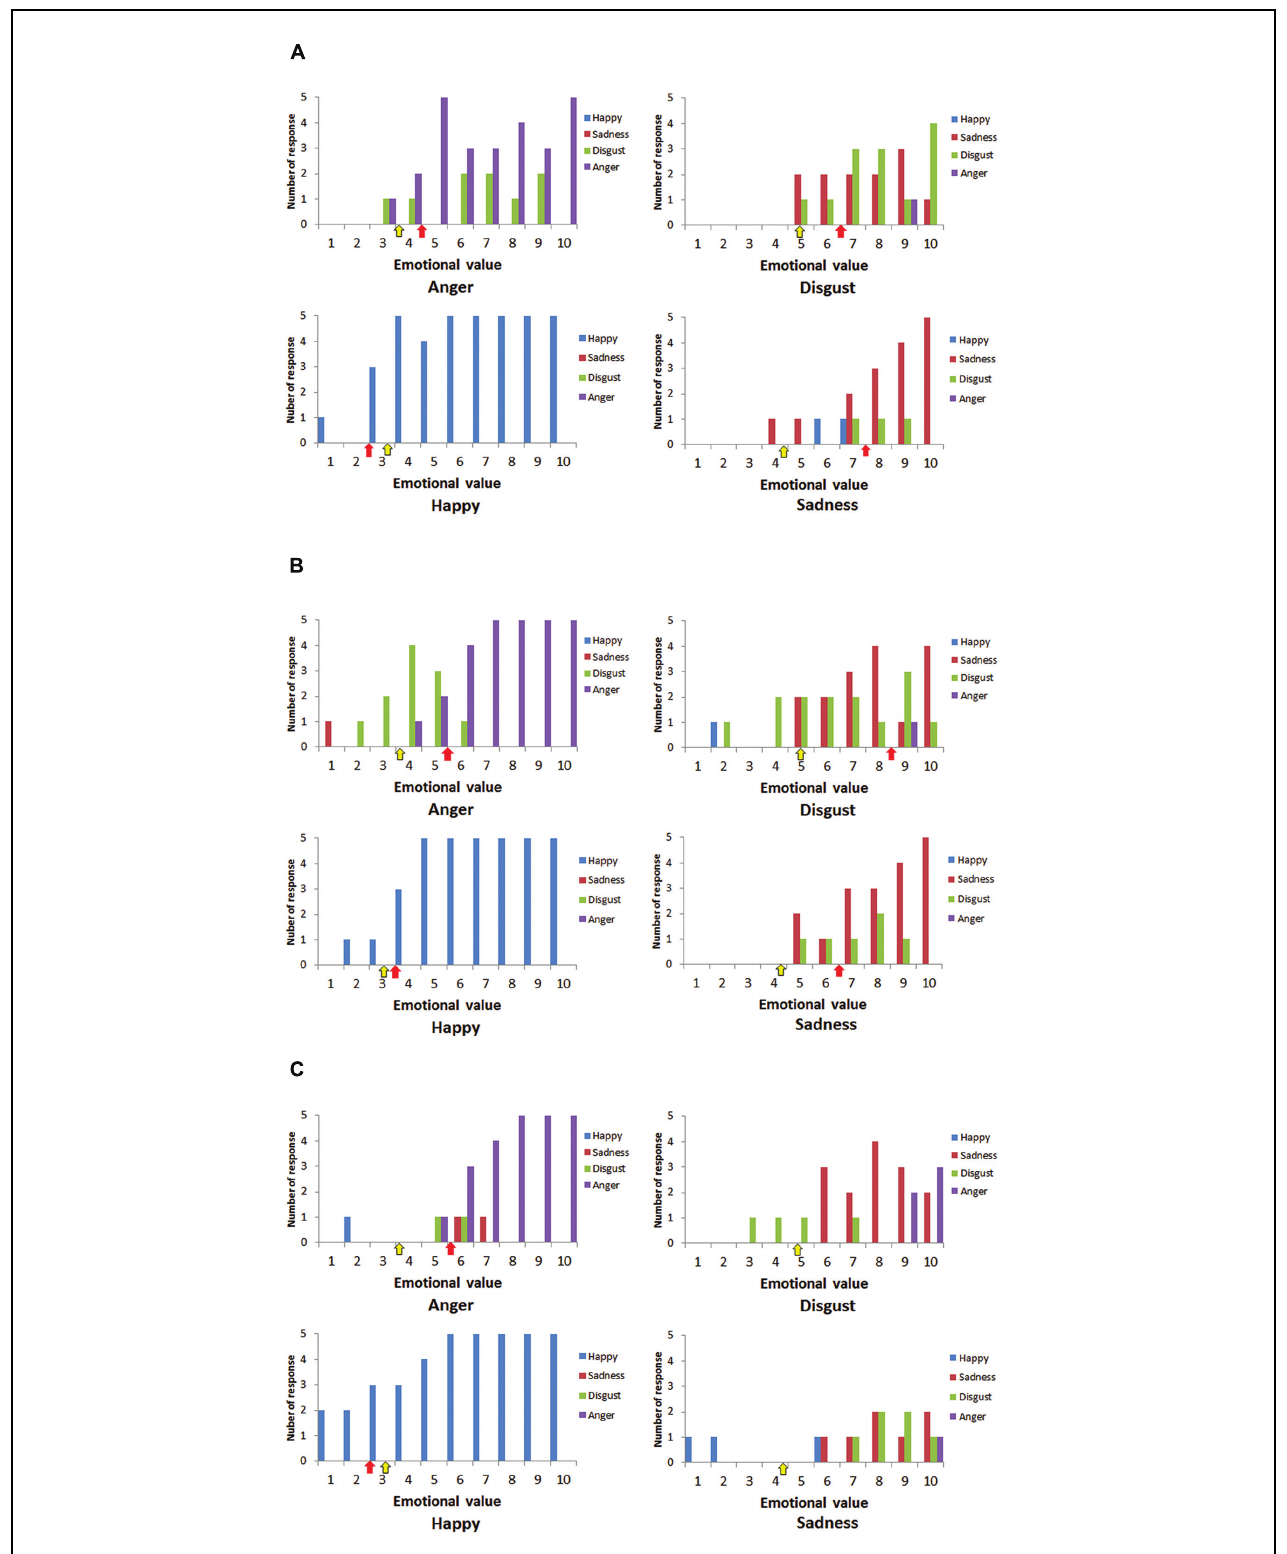
FIGURE 3 | Numbers of responses for happiness (blue), sadness (red), disgust (green), and anger (purple) for each stimulus. (A) Case A, (B) Case B, and (C) Case C. Red arrows show the place where the thresholds of cases appeared, and yellow arrows show the averaged thresholds of healthy participants.